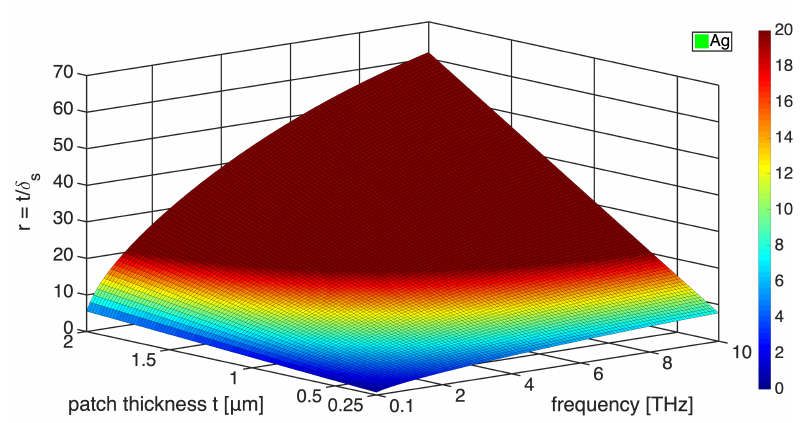
Figure 4. A 3 D representation of the ratio metal thickness to penetration depth r = t / δ s ( δ s : penetra- tion depth, t : thickness of metallic portions) for Ag at 0.1–10 THz frequency range. The color scale represents the values of the ratio r .